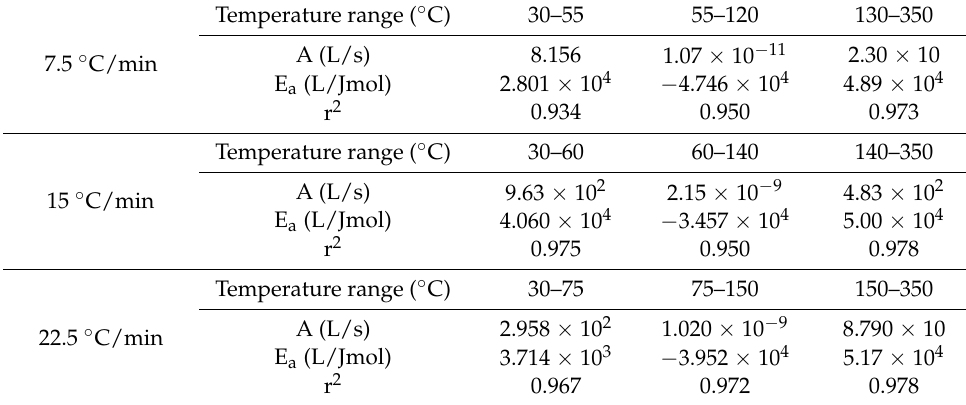
Table 6. Frequency factor and activation energy of perilla from TGA